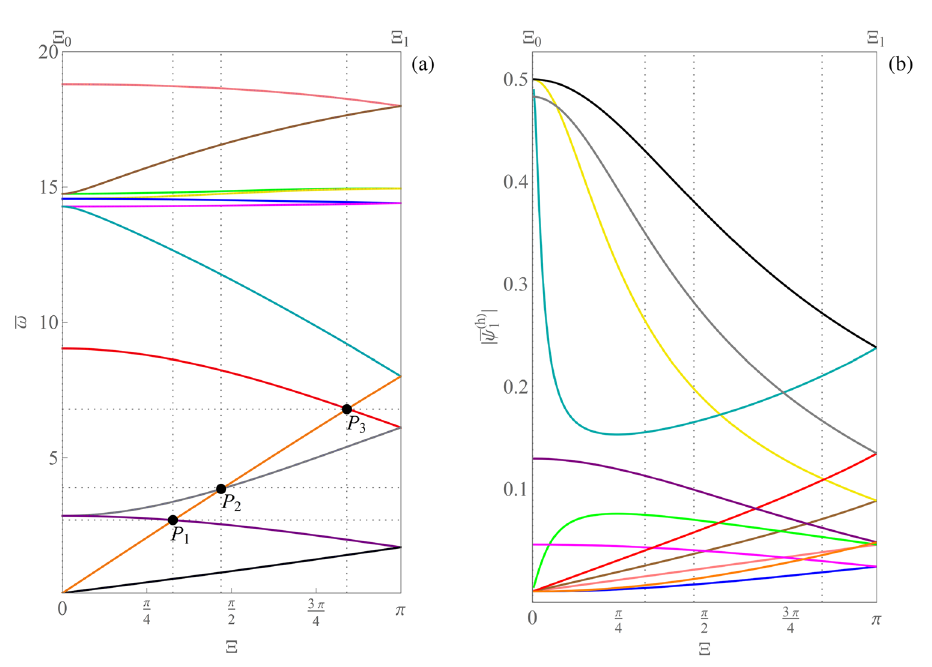
Figure 8. ( a ) Dispersion curve coloring obtained by Algorithm 1. ( b ) Continuity of the magnitude components | corresponding to the generalized eigenvector curves, labeled in accordance with the results reported in | ¯ ψ ( h ) 1 part ( a ) of the